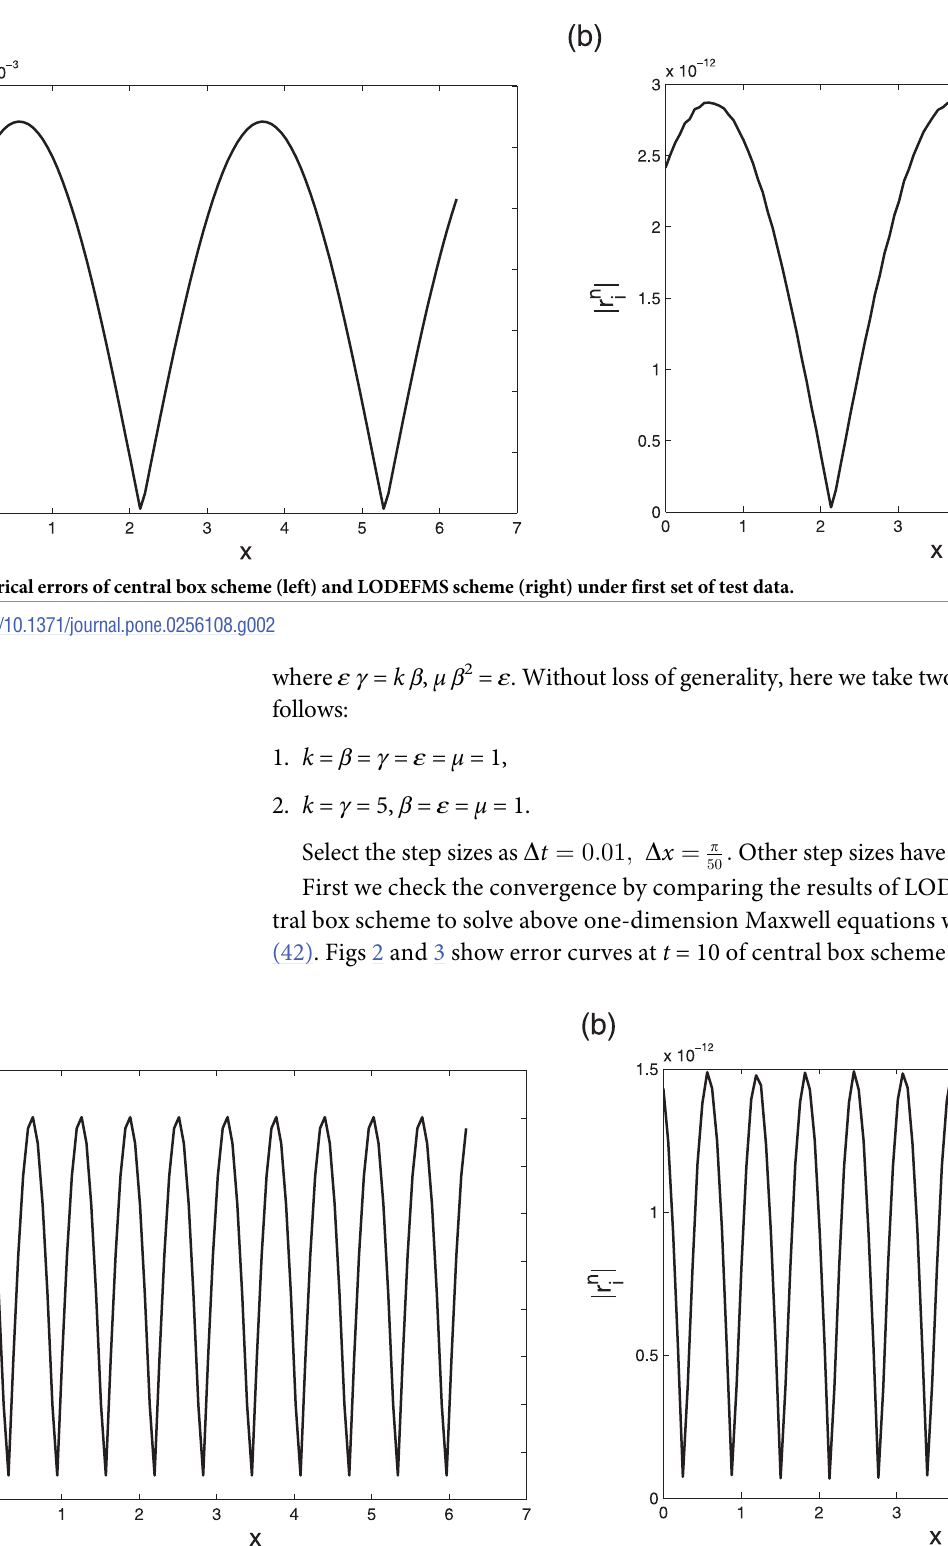
Fig 3. Numerical errors of central box scheme (left) and LODEFMS scheme (right) under second set of test data.